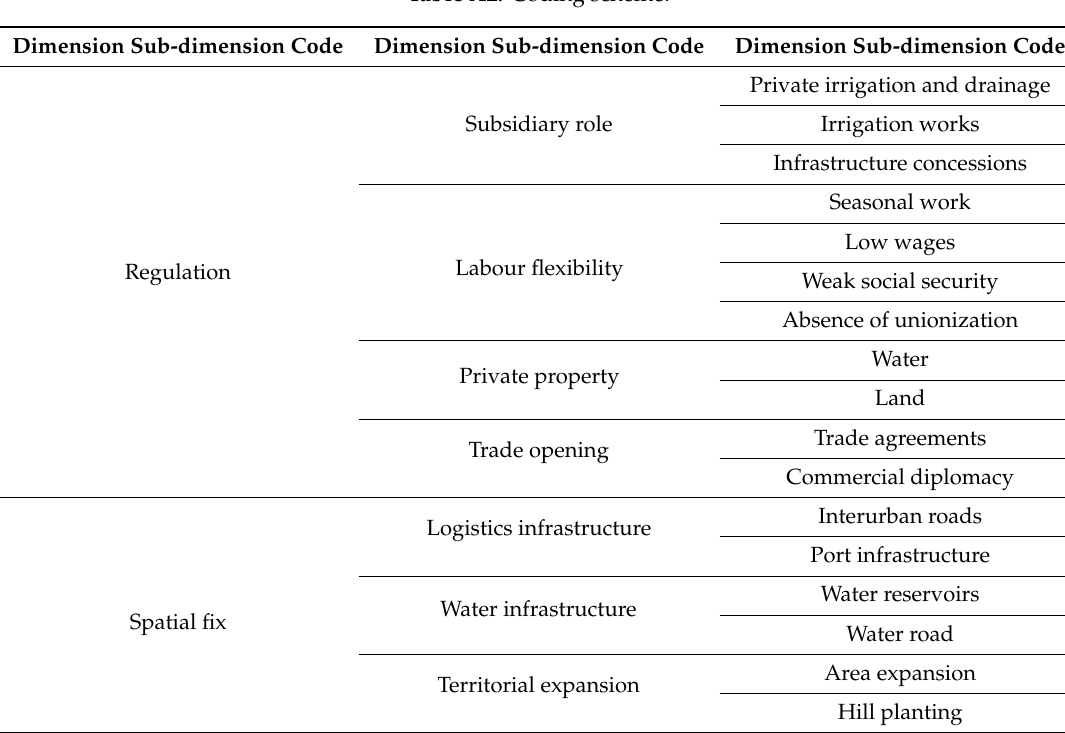
Table A2. Coding